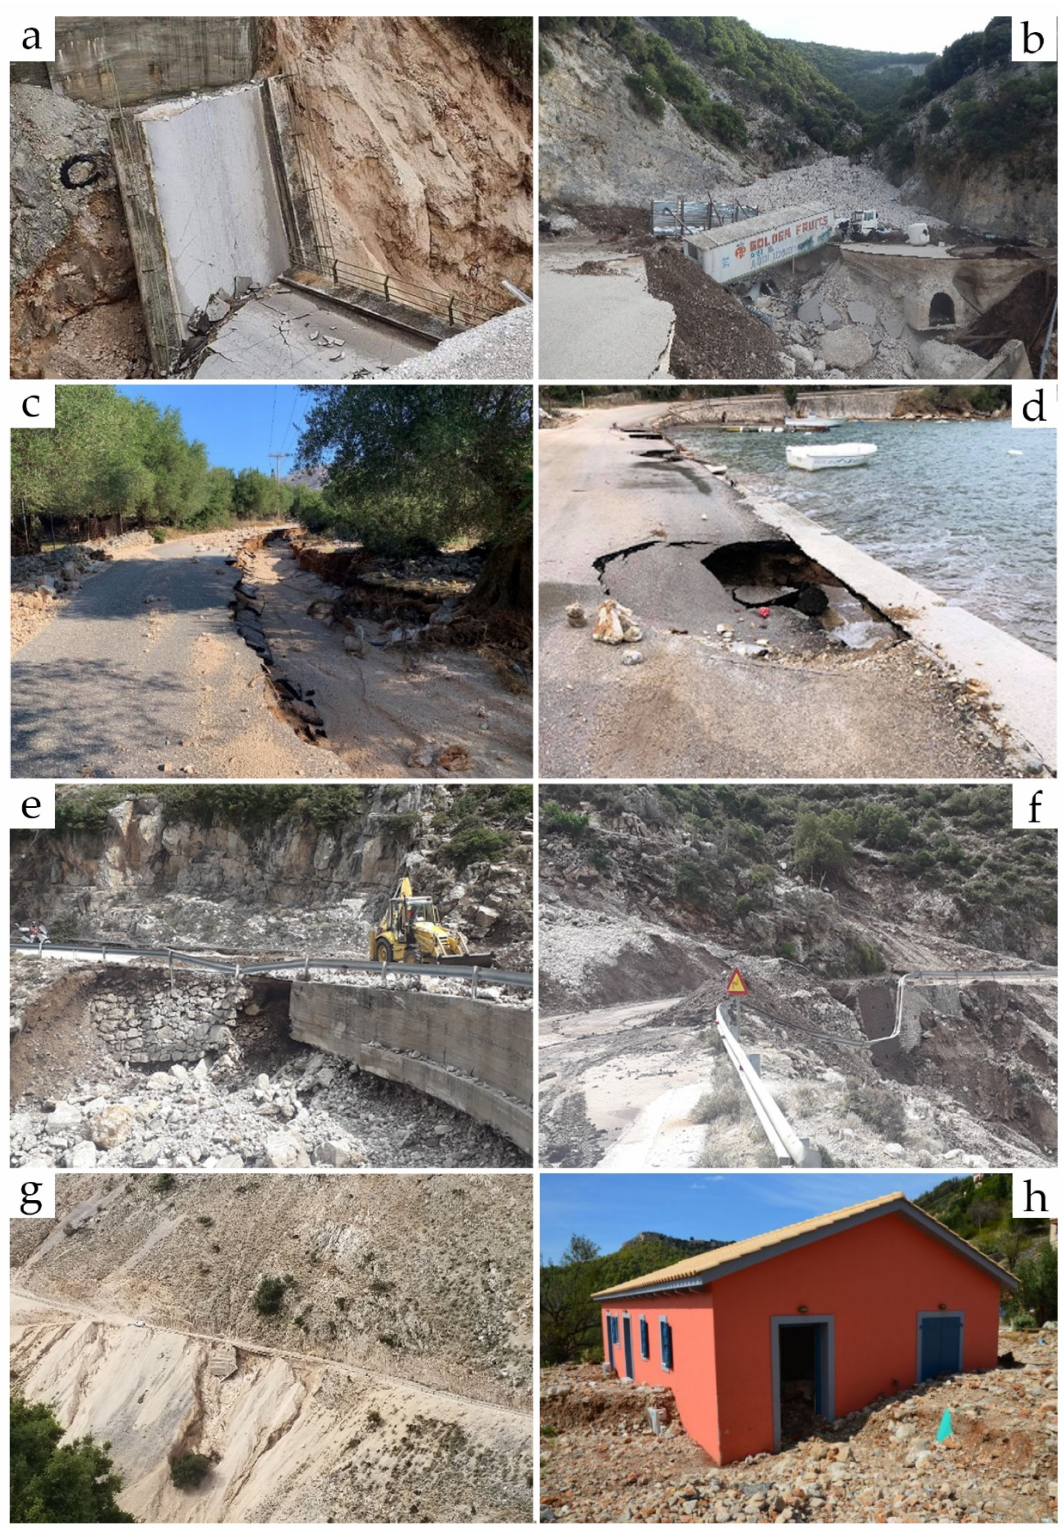
Figure 5. Characteristic images of impacts on infrastructure including ( a , b ) collapsed bridges in Cephalonia, ( c , d ) road embankment scouring, undercutting and erosion in Ithaki, ( d – f ) road embankment collapses in Cephalonia, ( g ) road subsidence and slope failure, and ( h ) building structural